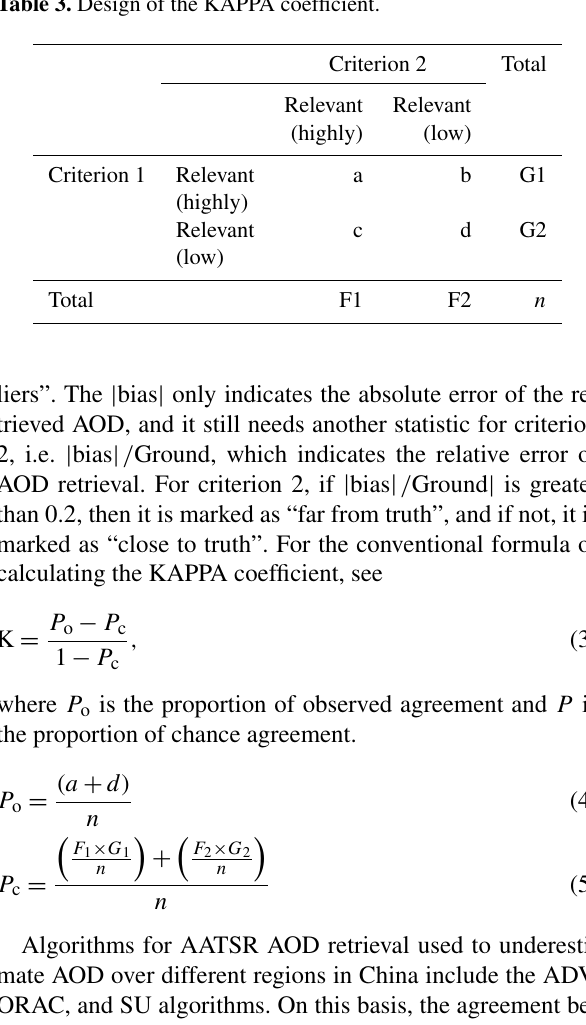
Table 3. Design of the KAPPA